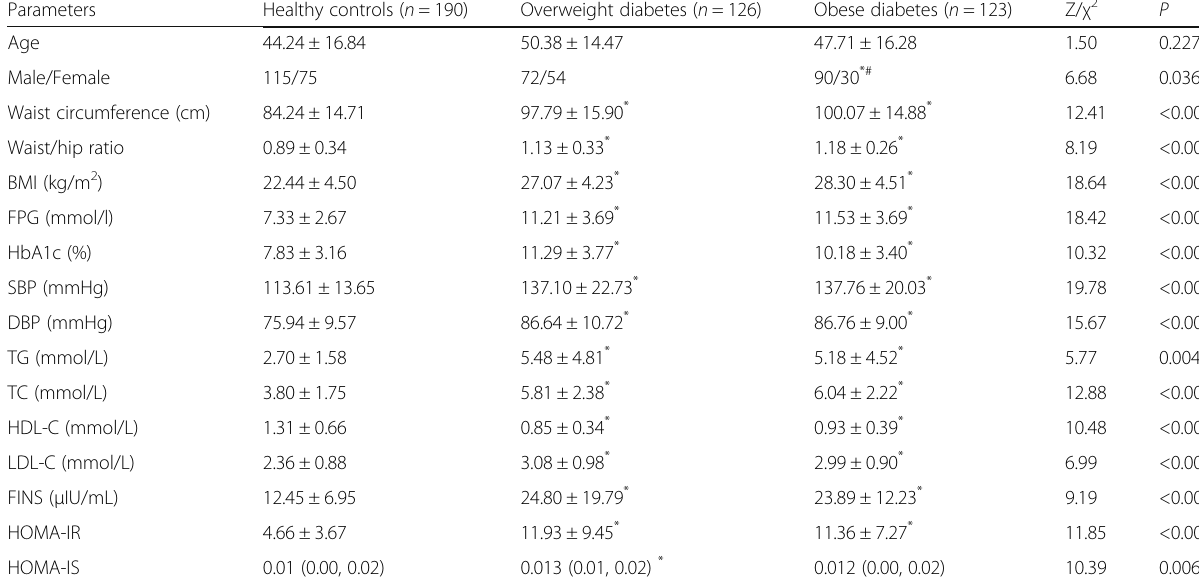
Table 3 Clinical characteristics of healthy controls and type 2 diabetic patients with overweight or obesity Parameters